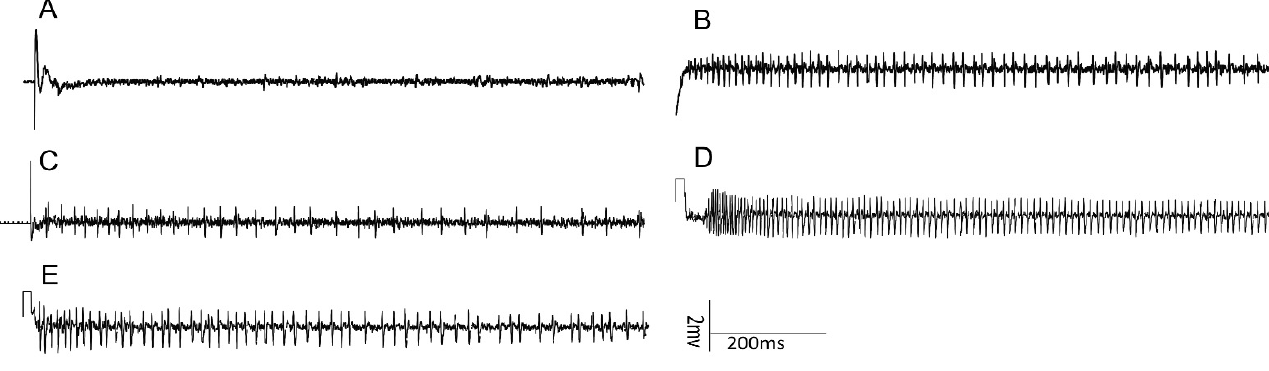
Figure 4. Exemplary recordings of electrophysiological activity in medial sensilla styloconica on the maxillary galea of 5th instar H. armigera and H. assulta caterpillars reared on standard artificial diet or on artificial diet containing strychnine: ( A ) control (KCl 2 mM); ( B ) strychnine 1 mM on H. armigera caterpillars reared on standard artificial diet; ( C ) strychnine 1 mM on H. armigera caterpillars exposed to strychnine-containing diet for 72 h; ( D ) strychnine 1 mM on H. assulta caterpillars reared on standard artificial; ( E ) strychnine 1 mM on H. assulta caterpillars reared on artificial diet containing strychnine for 48 h. The onset of the stimulations occurred at the start of each trace.